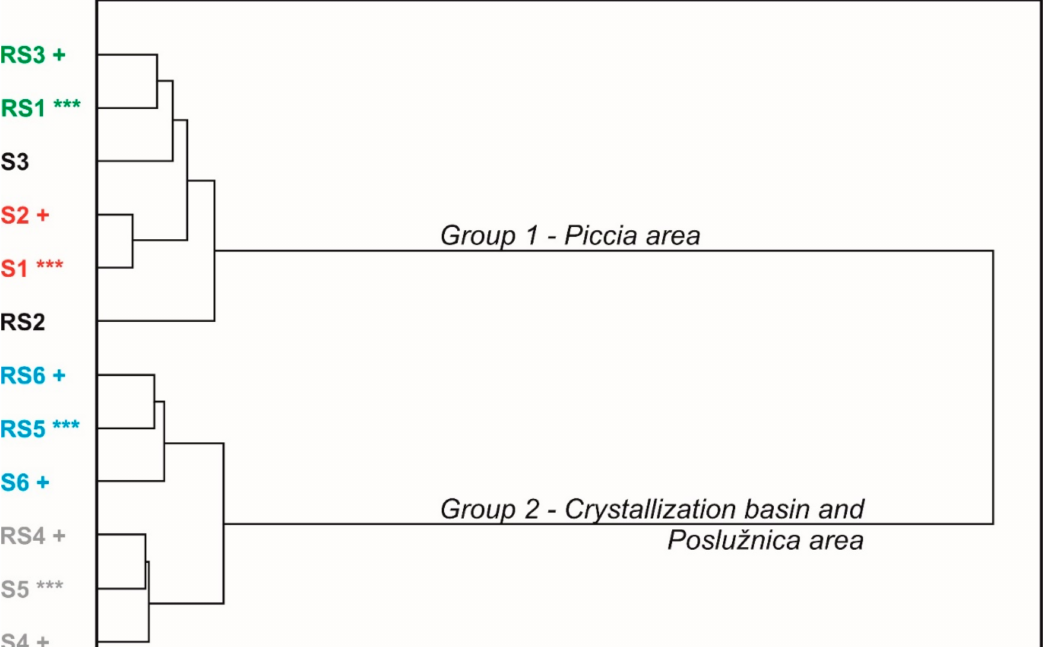
Figure 6. Sediment and rhizo-sediment sample (S1, RS1, S2, RS2, S3 and RS3 originate from Piccia area; S4, RS4, S5 and RS5 originate from crystallization basin; S6 and RS6 originate from Poslužnica area) dendrogram based on Ward’s method and the squared Euclidean